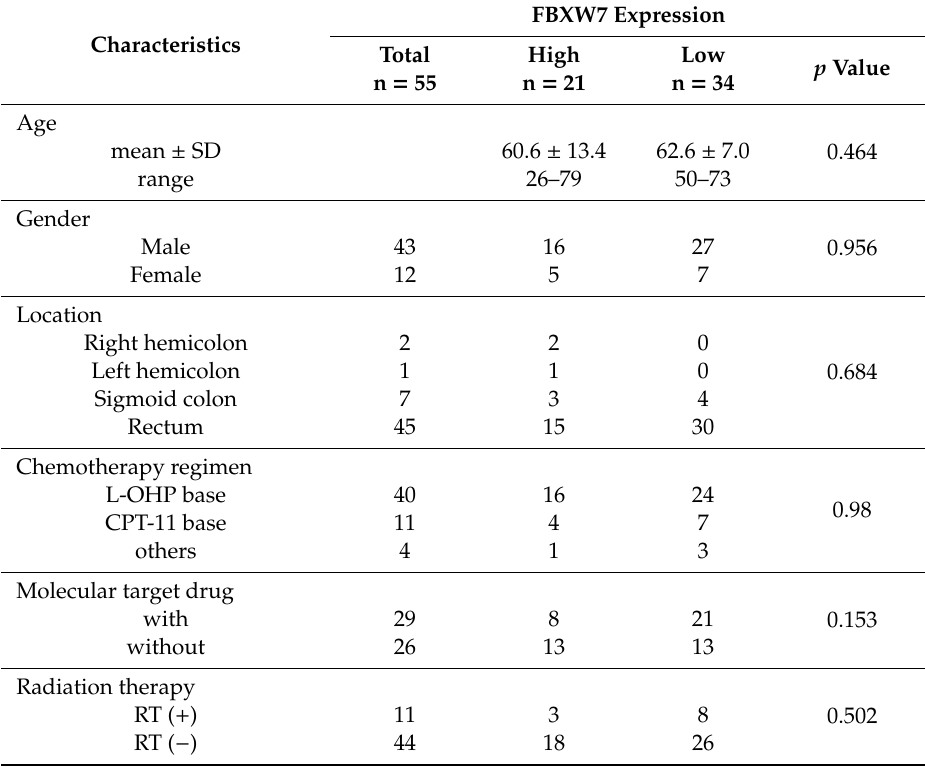
Figure 1. High FBXW7 expression in pre-treatment biopsy specimens is related to poor pathological therapeutic e ff ect. ( A ) IHC staining for FBXW7 in representative pre-treatment biopsy specimens. Left panel shows high FBXW7 expression and right panel shows low FBXW7 expression. Scale bars, 100 µ m. ( B ) Correlation between FBXW7 expression in pre-treatment biopsy specimens and the pathological therapeutic e ff ect of NAC / NACRT in surgically resected specimens. X-axis, number of cases. Table 1. Correlation between FBXW7 expression and clinicopathological features in 55 patients with CRC treated with NAC / NACRT before surgical